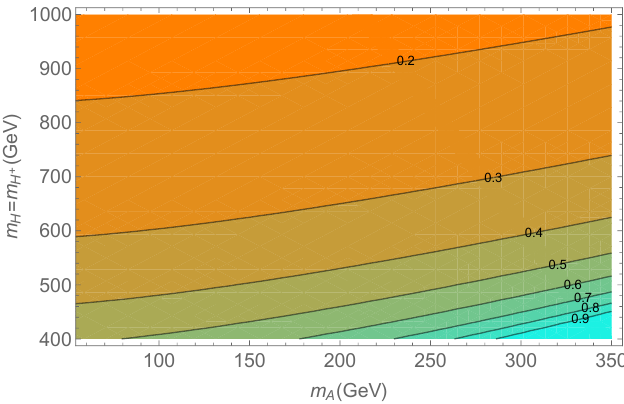
Figure 1. Contours of the upper limit on j c (cid:12) (cid:0) (cid:11) j , such that the bound on the T parameter, (cid:0) 0 : 17 (cid:20) T (cid:20) 0 : 35 at 95% C.L. [9], is